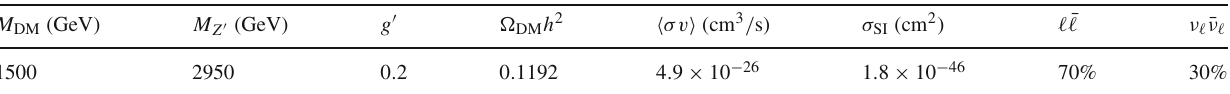
Table 2 The DM information for benchmark point to fit DAMPE excess. Here (cid:12) σv (cid:13) is thermal averaged cross section at present. The last two columns present relative contributions for various annihilation channels